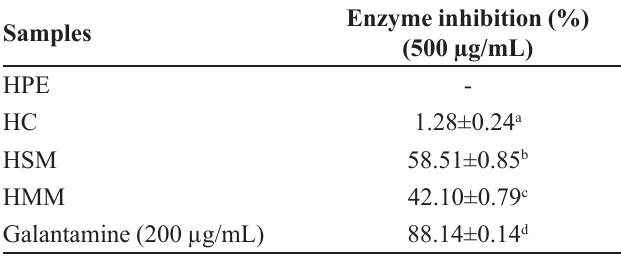
TABLE V - The anticholinesterase activity of different extracts from H. plicatum subsp.